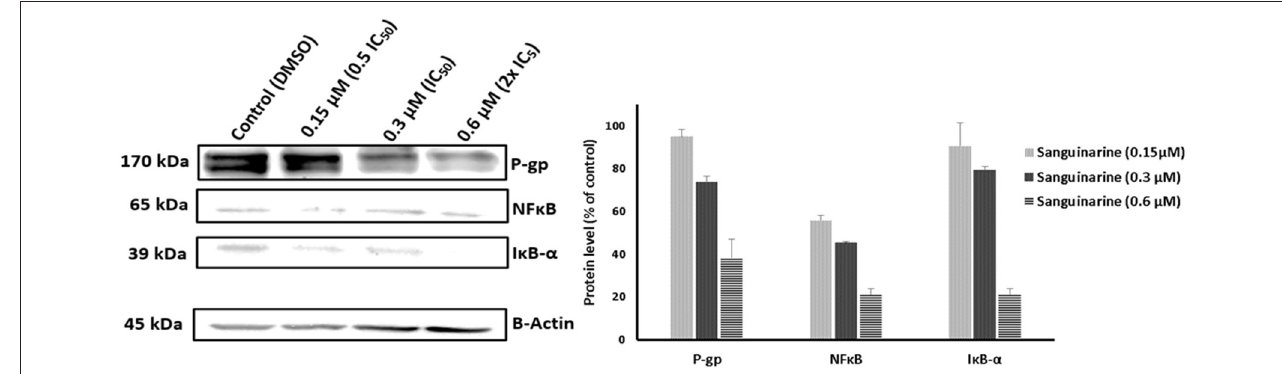
FIGURE 8 | Western blot analysis of the effect of Sanguinarine on CEM/ADR5000 leukemia cells. Evaluation of the P-gp, NF κ B, and I κ B α expressions. β -actin was used as loading control. Bands were normalized to β -actin in order to obtain numerical values (Mean ± SD ).